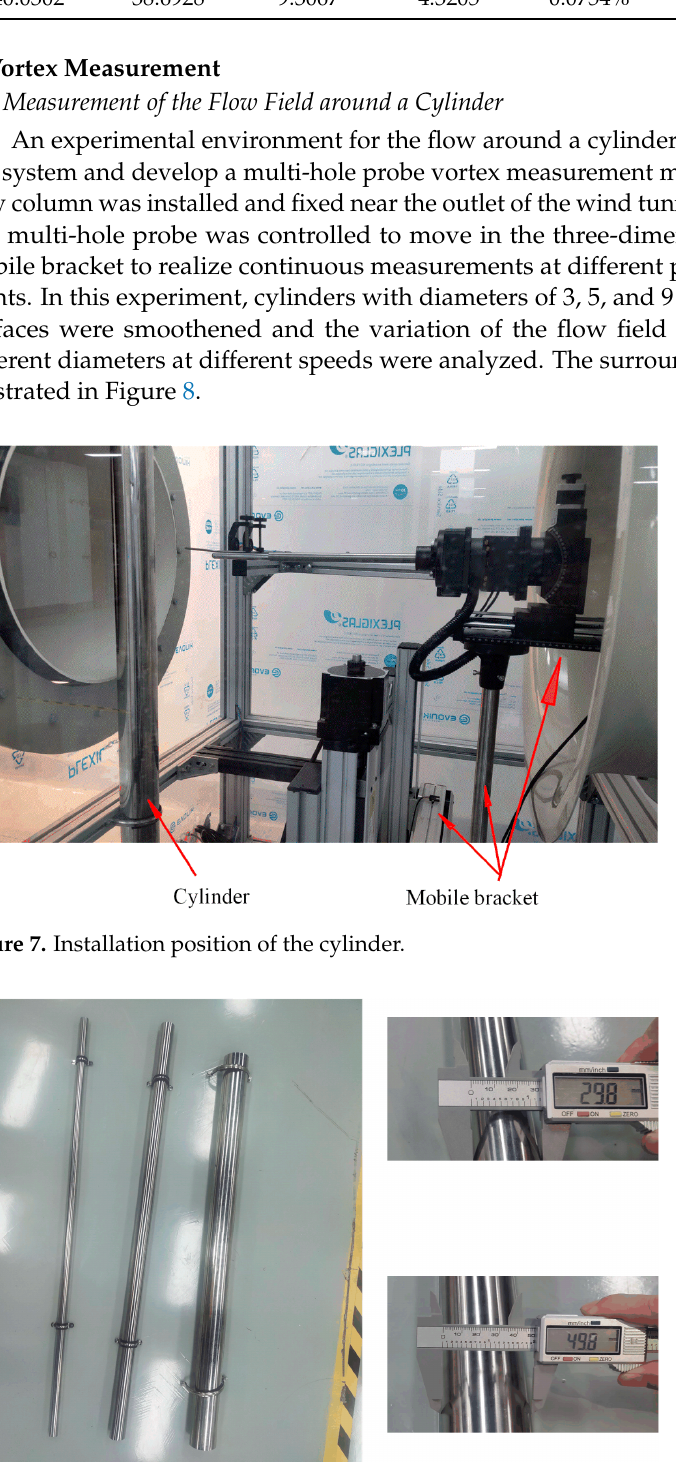
Figure 8. Cylinders of different sizes.